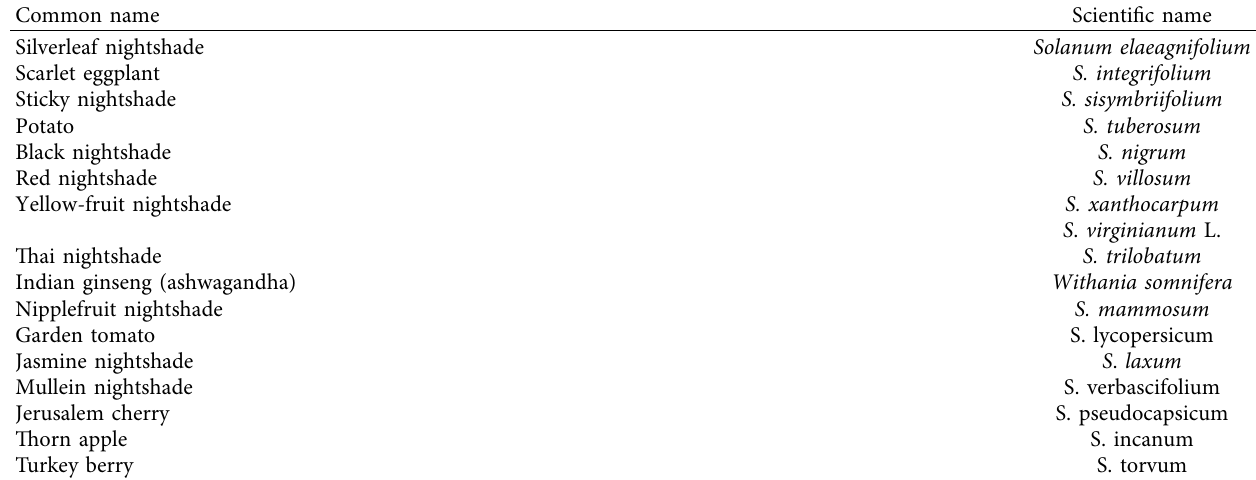
Table 2: Common and scientific names of Solanum spp.